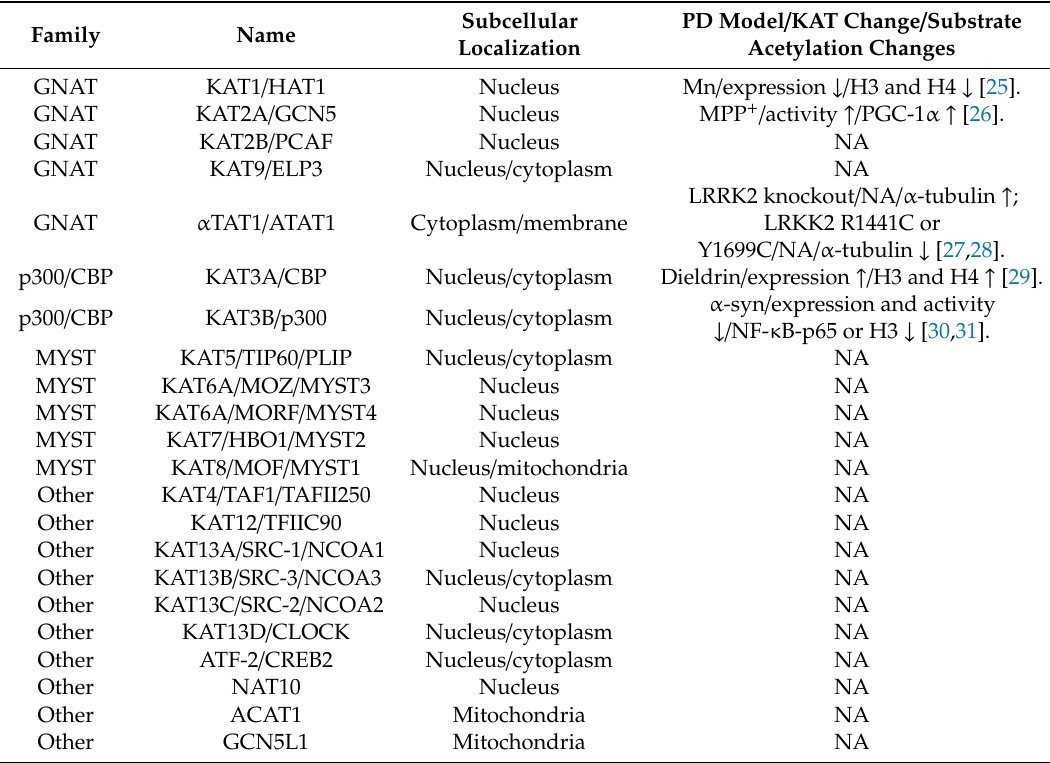
Table 2. Human KATs and their Involvement in